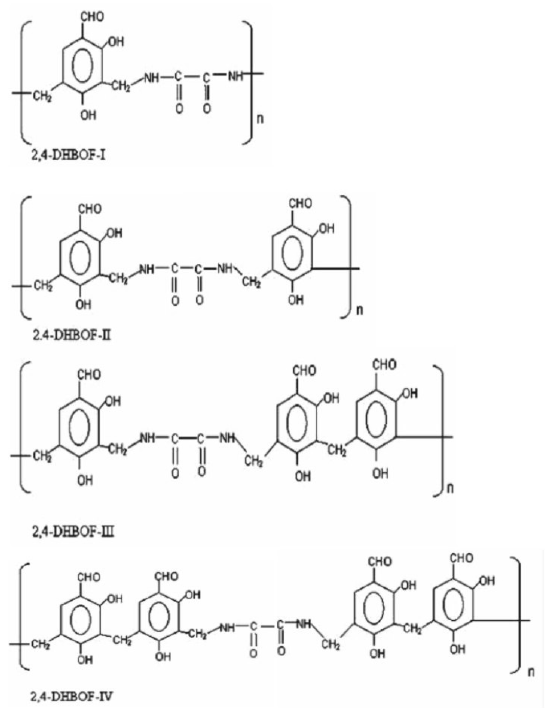
Figure 5. The suggested structures of 2, 4-DHBOF terpolymer